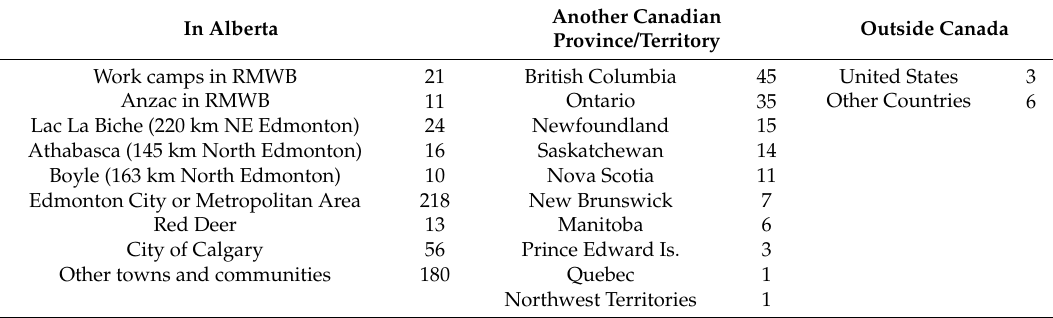
Table 5. Where survey respondents stayed during their evacuation (n = 163).